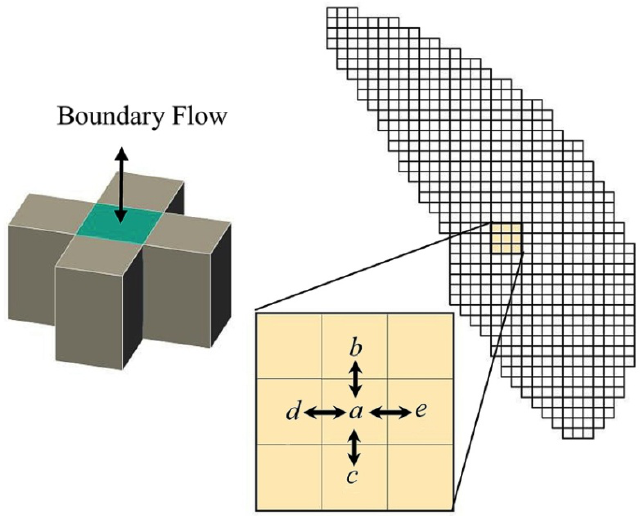
Figure 3. Aquifer discretization and groundwater modeling paradigm in the system dynamics